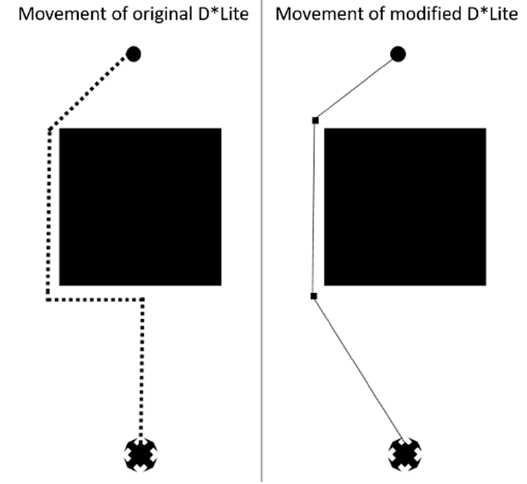
Figure 9. Comparison of drone movement methods.